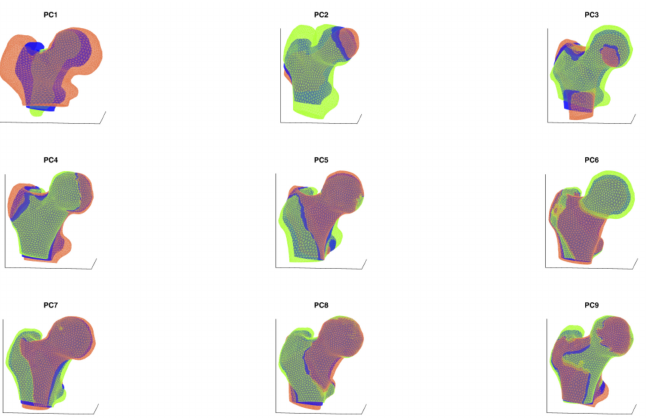
Figure 4. The first nine proximal femurs principal components (PCs). The average femur shape is represented in blue, while the deformations along the i th PC applying a weight equal to reported in green/brown.